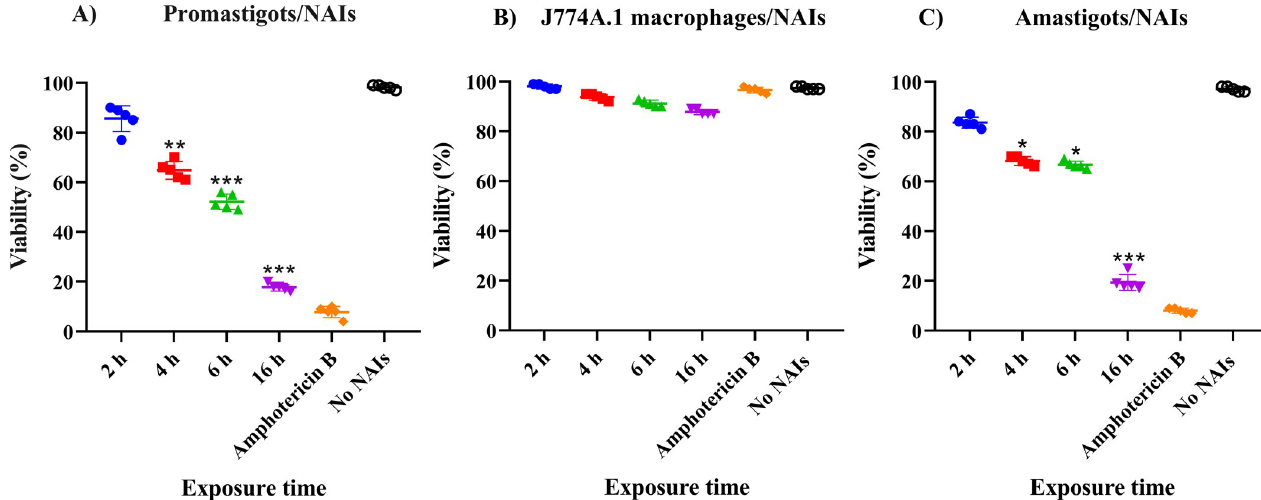
Fig 1. Cell viability and in vitro anti-leishmanial effects of NAIs (10 6 NAI/cm 3 ) on L . major promastigotes (A), the macrophage cell line J774A.1 (B) and on macrophages infected with L . major amastigotes (C), at exposure times of 2 h, 4 h, 6 h and 16 h. Amphotericin B (1.9 μ g/mL) and PBS 1X were applied as positive (reference drug) and negative controls, respectively for 2, 4, 6 and 16 h. As there was no difference in all four time-points, only the results for 16 h exposure are shown. The data are shown as the mean ± SD of three consecutive repeated tests with identical results that were carried out in triplicate, which statistical test was used P value descriptions as in the other figures. ( � P < 0.05, �� P < 0.01, ��� P < 0.001).